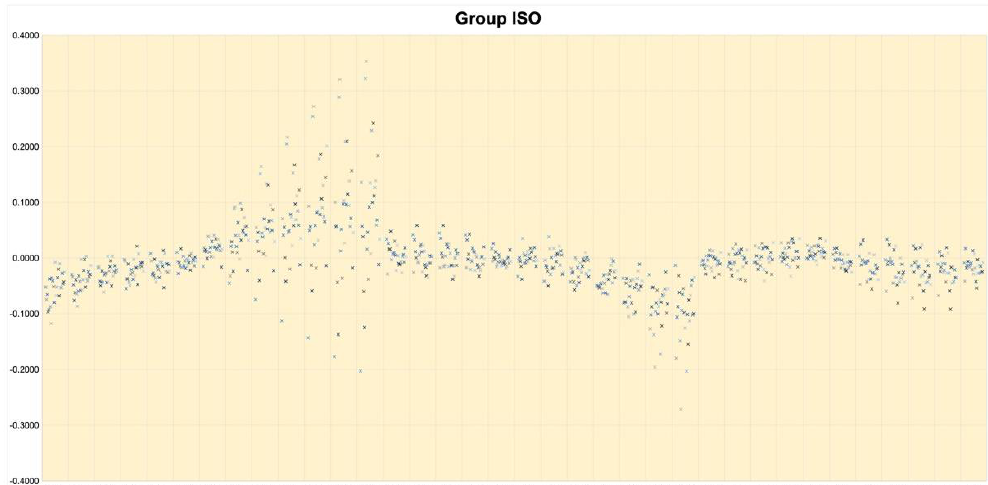
Figure 8. Distribution of Δx, Δy, and Δz in Group ISO. Vertical axis represents the amount of difference between the master model and digital models (trueness values) in millimeters. Horizontal axis represents the cylinder position according to the axis (i.e., X17 represented Δx at cylinder 17).